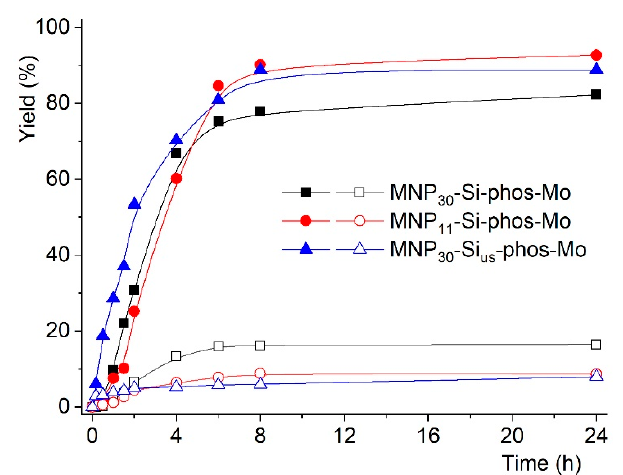
Figure 6. Reaction kinetics of trans -hex-2-en-1-ol epoxidation, in toluene at 383 K, concerning yield of the epoxide (closed symbols) and α -hydroxy ketone (open symbols) products.